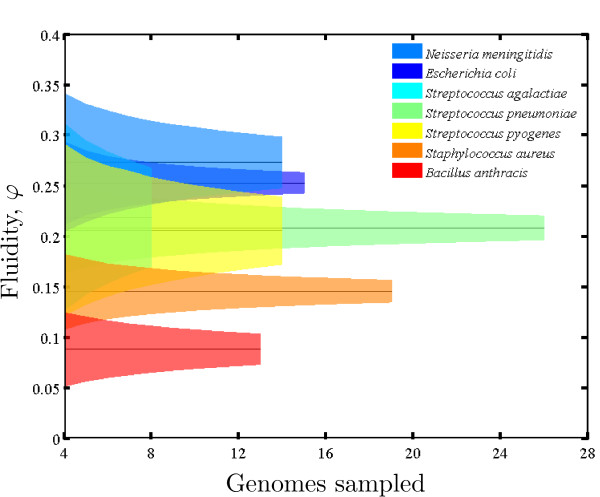
Estimates of mean fluidity converge with increases in sampled genomes. Fluidity was calculated as described in the text given alignment parameters i = 0.74 and c = 0.74. The variance of fluidity is estimated as a total variance, containing both the variance due to subsampling within the sample of genomes, and the variance due to the limited number of sampled genomes. For dependence of fluidity on genomes sampled for the two other sets of alignment parameters in Figure 5, see Additional file 1, Figures S3-S4.